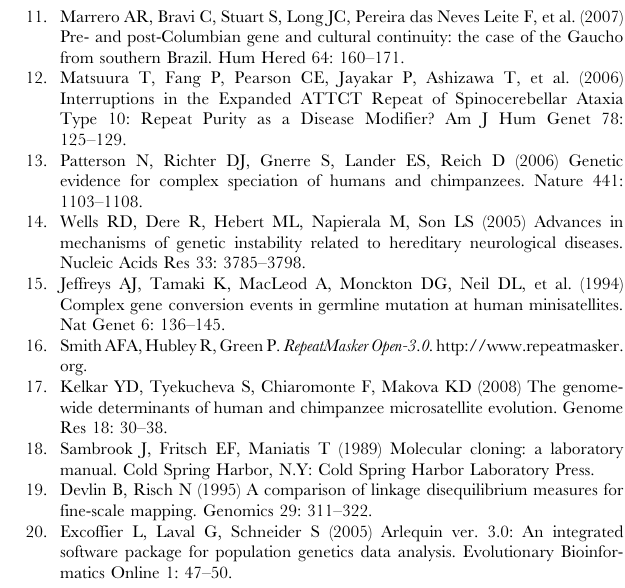
Table S1 Haplotype frequencies by control population